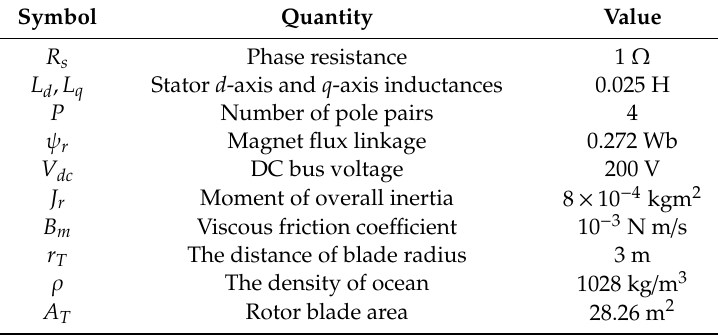
Table 1. Parameter Values of the PMSG–HTs.